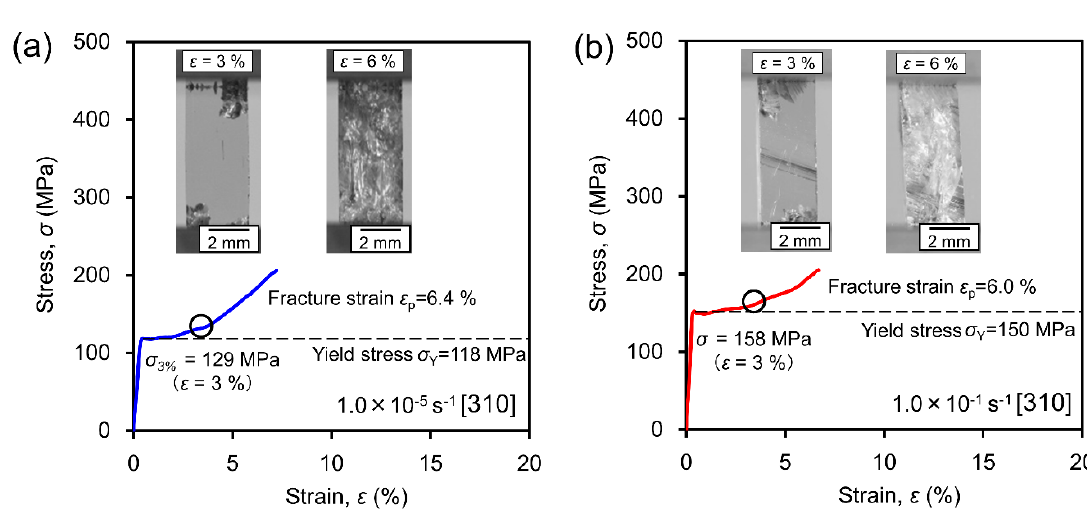
Figure 1. Stress-strain curves and corresponding real-time images captured during deformation for bulk deformation on single crystal SrTiO 3 along the [310] direction: ( a ) Strain rate 1.0 × 10 −5 s −1 ; ( b ) Strain rate 1.0 × 10 −1 s −1 .